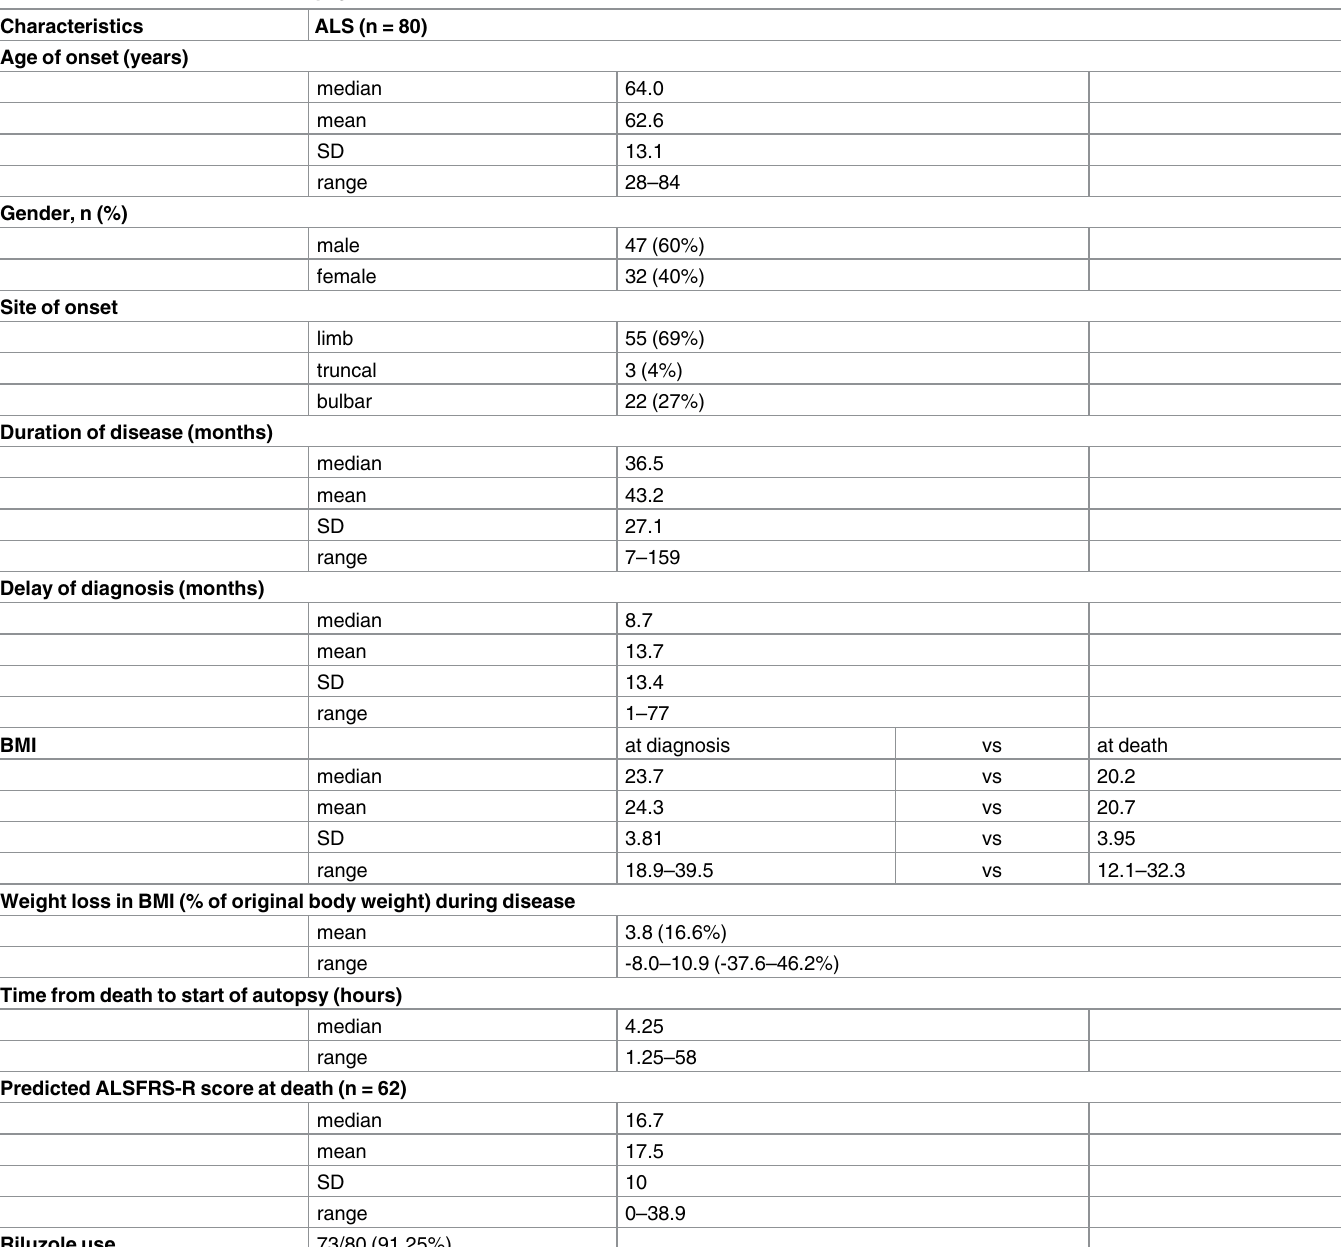
Table 1. Characteristic of the autopsy